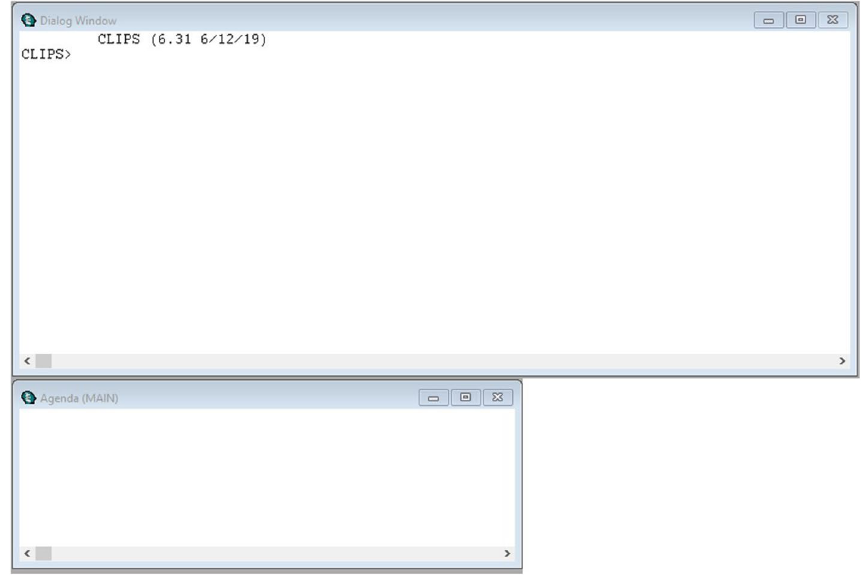
Fig. 10 Windows dialog and schedule in CLIPS (Source: Giarratano